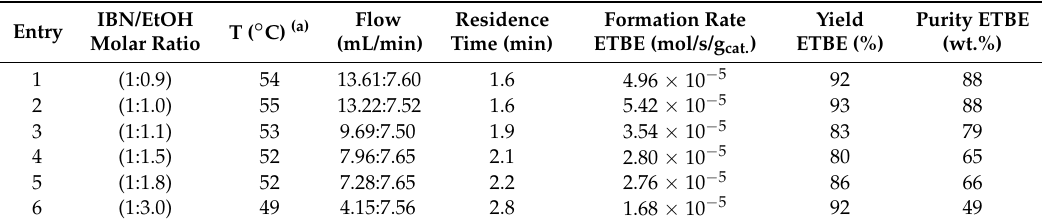
Table 3. Data set for the optimization of continuous processing for bio-sourced ETBE formation (process pressure 2.4 MPa, catalyst volume 33